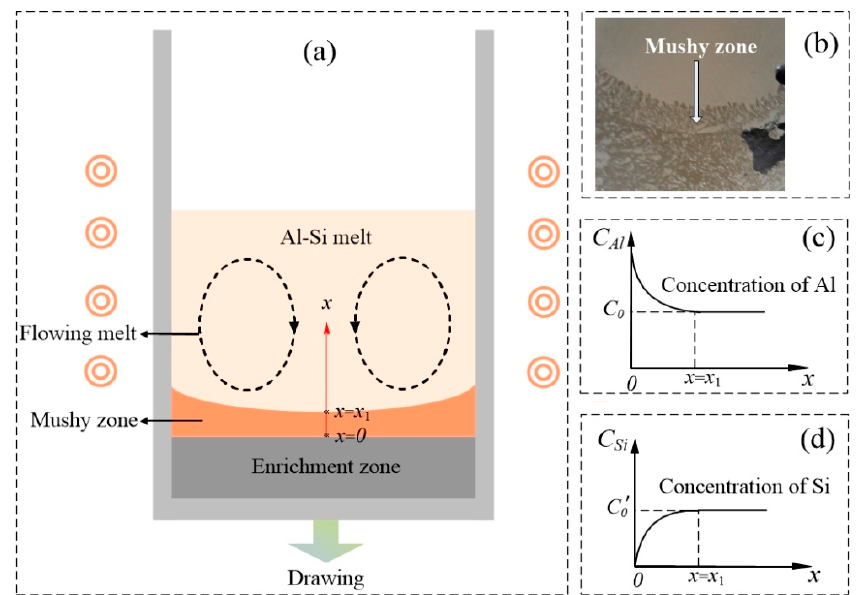
Figure 6. ( a ) Schematic of a plausible Si macrosegregation mechanism, ( b ) cross-section of the directionally solidified sample, ( c ) concentration distributions of Al in the mushy zone, and ( d ) concentration distributions of Si in the mushy zone.